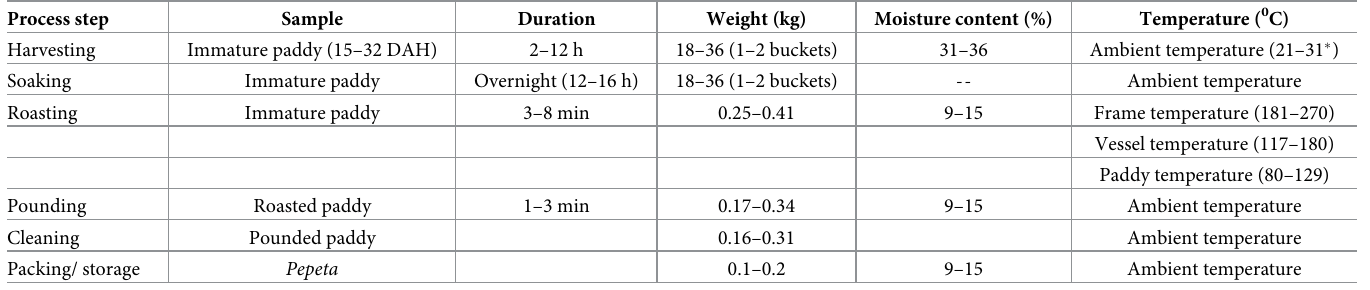
Table 5. Moisture content, duration, weight and temperature at various processing steps of pepeta product.